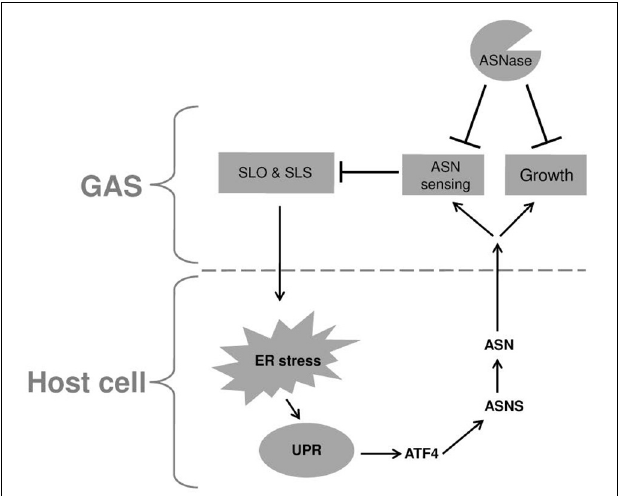
FIGURE 2 | A model describing the reciprocal relationship between GAS and infected host cell. Upon adherence, GAS delivers the SLO and SLS toxins to the host cell. These toxins induce ER stress causing UPR, which in turn is responsible for the elevated transcription of asns gene through the PERK-eIF2-ATF4 pathway. The enhanced activity of ASNS leads to release of ASN to the culture medium which is sensed by GAS, resulting in reduced transcription of both SLO and SLS. In addition, GAS utilizes the released ASN to enhance its rate of proliferation. Both effects of host ASN on GAS can be inhibited by the addition of bacterial ASNase a widely used chemotherapeutic